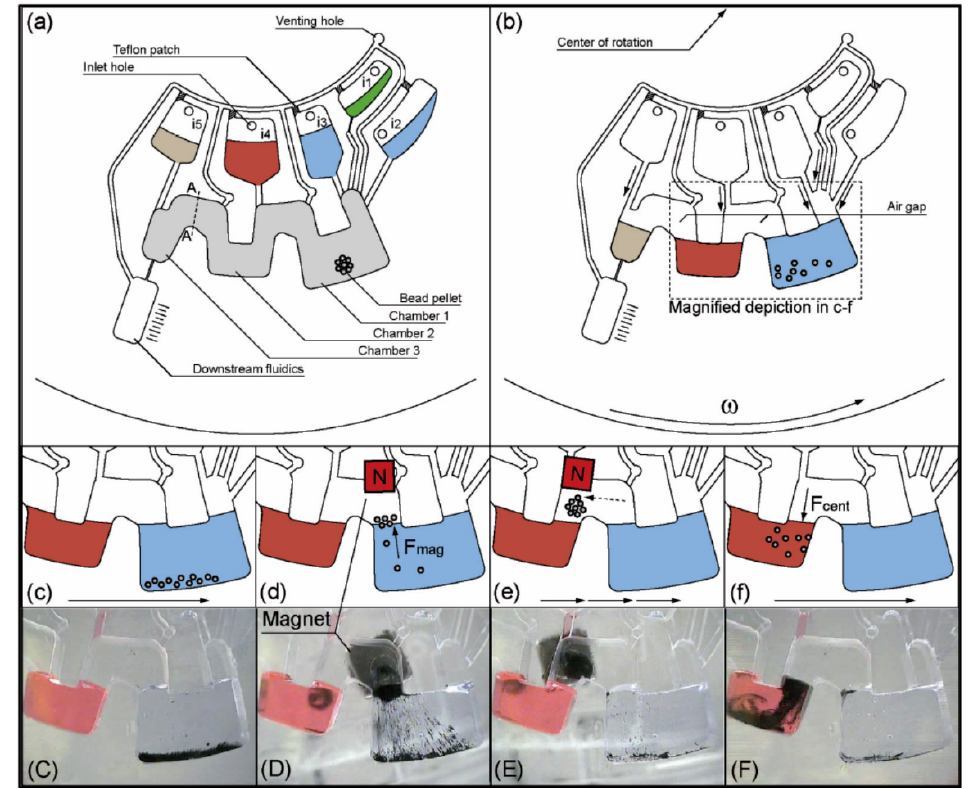
Figure 6. Gas-phase transition magnetophoresis system for DNA purification. Figure reprinted with permission from [73].